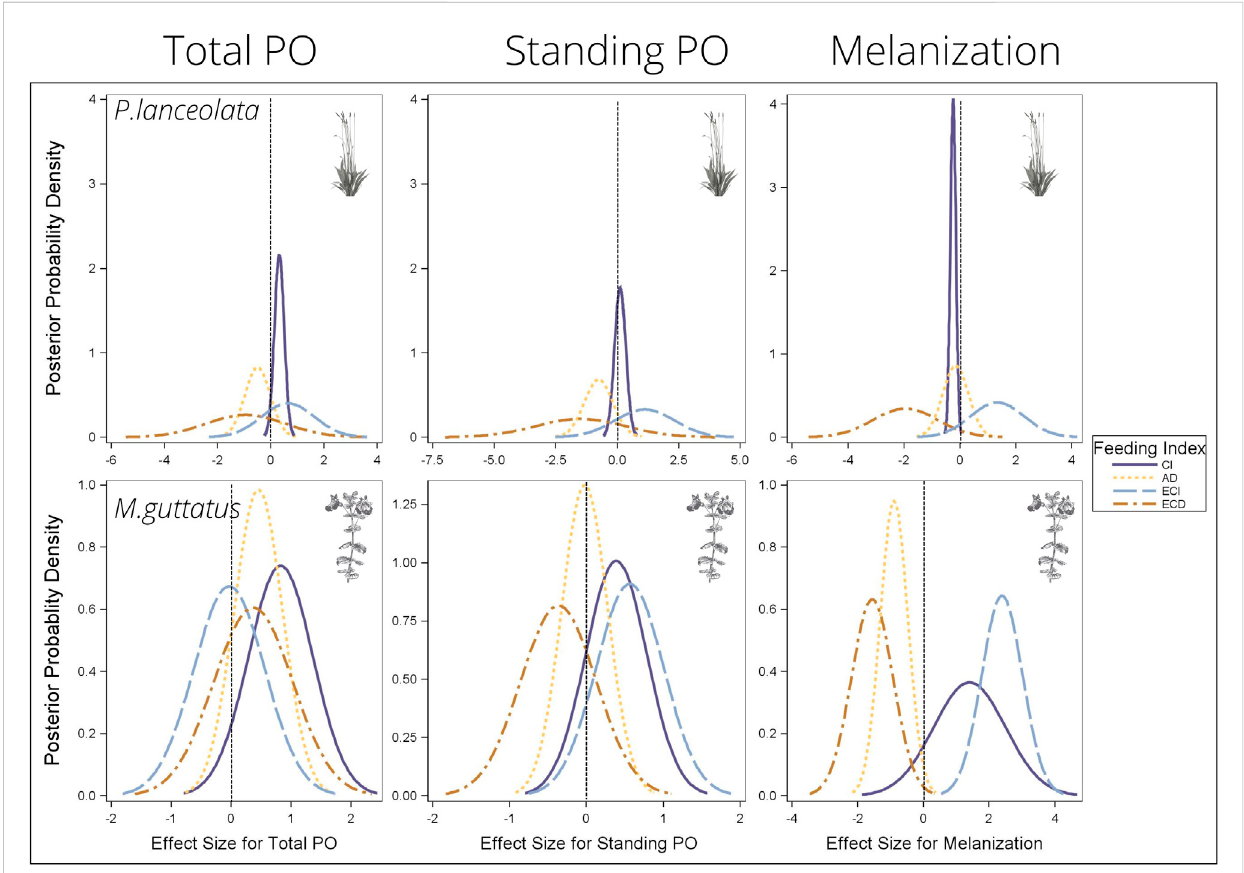
FIGURE 8 Bayesian posterior probability densities (PPDs) from the multiple regression analyses testing the effects of feeding ef fi ciency measurements on the three immune response parameters. The x -axis shows the effect size for each feeding ef fi ciency and immune response relationship. PPDs that are above zero indicate a positive relationship between feeding ef fi ciency and immunity, and PPDs that are below zero indicate a negative relationship between feedingef fi ciencyandimmunity.SeeTable1formeaneffectsizes,highestprobabilitydensityintervals,andposteriorprobabilities.CI=consumption index, AD = approximate digestibility, ECI = ef fi ciency of conversion of ingested food, ECD = ef fi ciency of conversion of digested food.